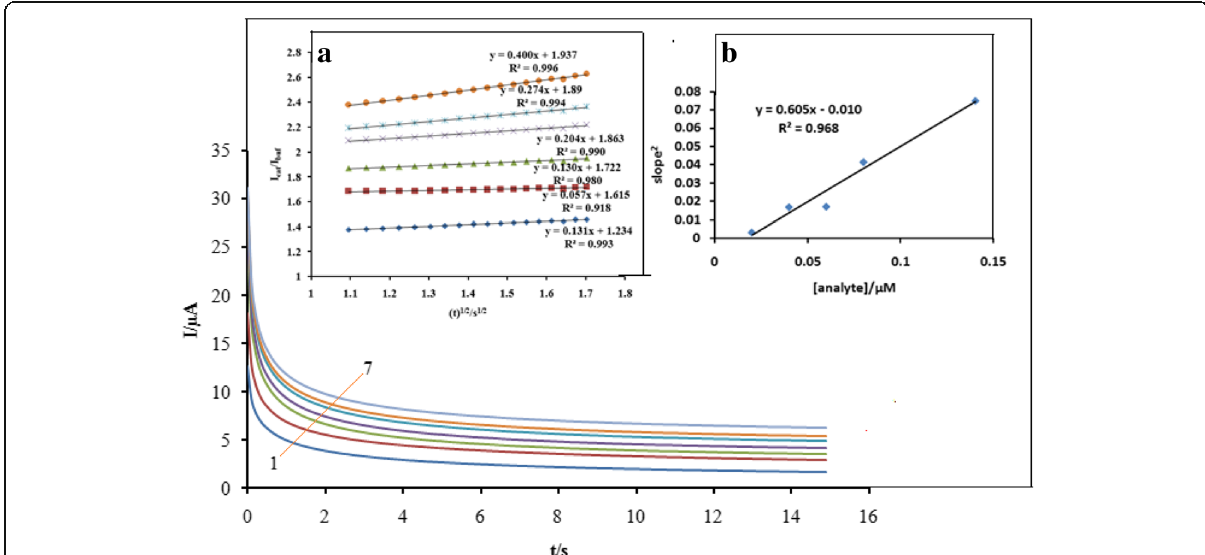
Fig. 9 Chronoamperogram for different paracetamol concentrations in 0.1 M PBS, curves 1 – 7: 0.02 – 0.14 μ M. Insets: (a) Plots of i ca t /i buffer vs. t 1/2 . (b) Slope 2 vs. [paracetamol